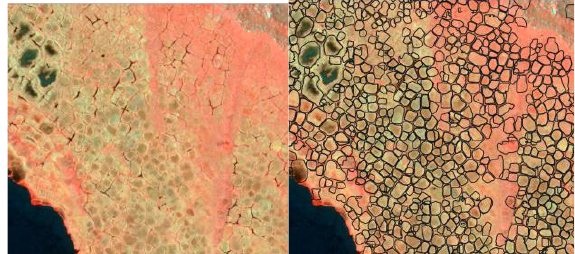
(a) The zoomed satellite image with ice-wedge polygons. (b) Plot of the ice-wedge polygons of the zoomed image. Imagery © 2016 DigitalGlobe,